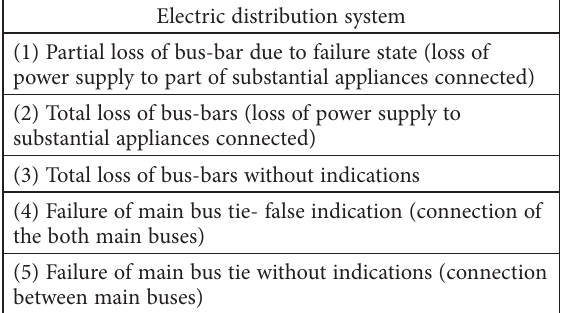
Table 2. Electric distribution system failure conditions